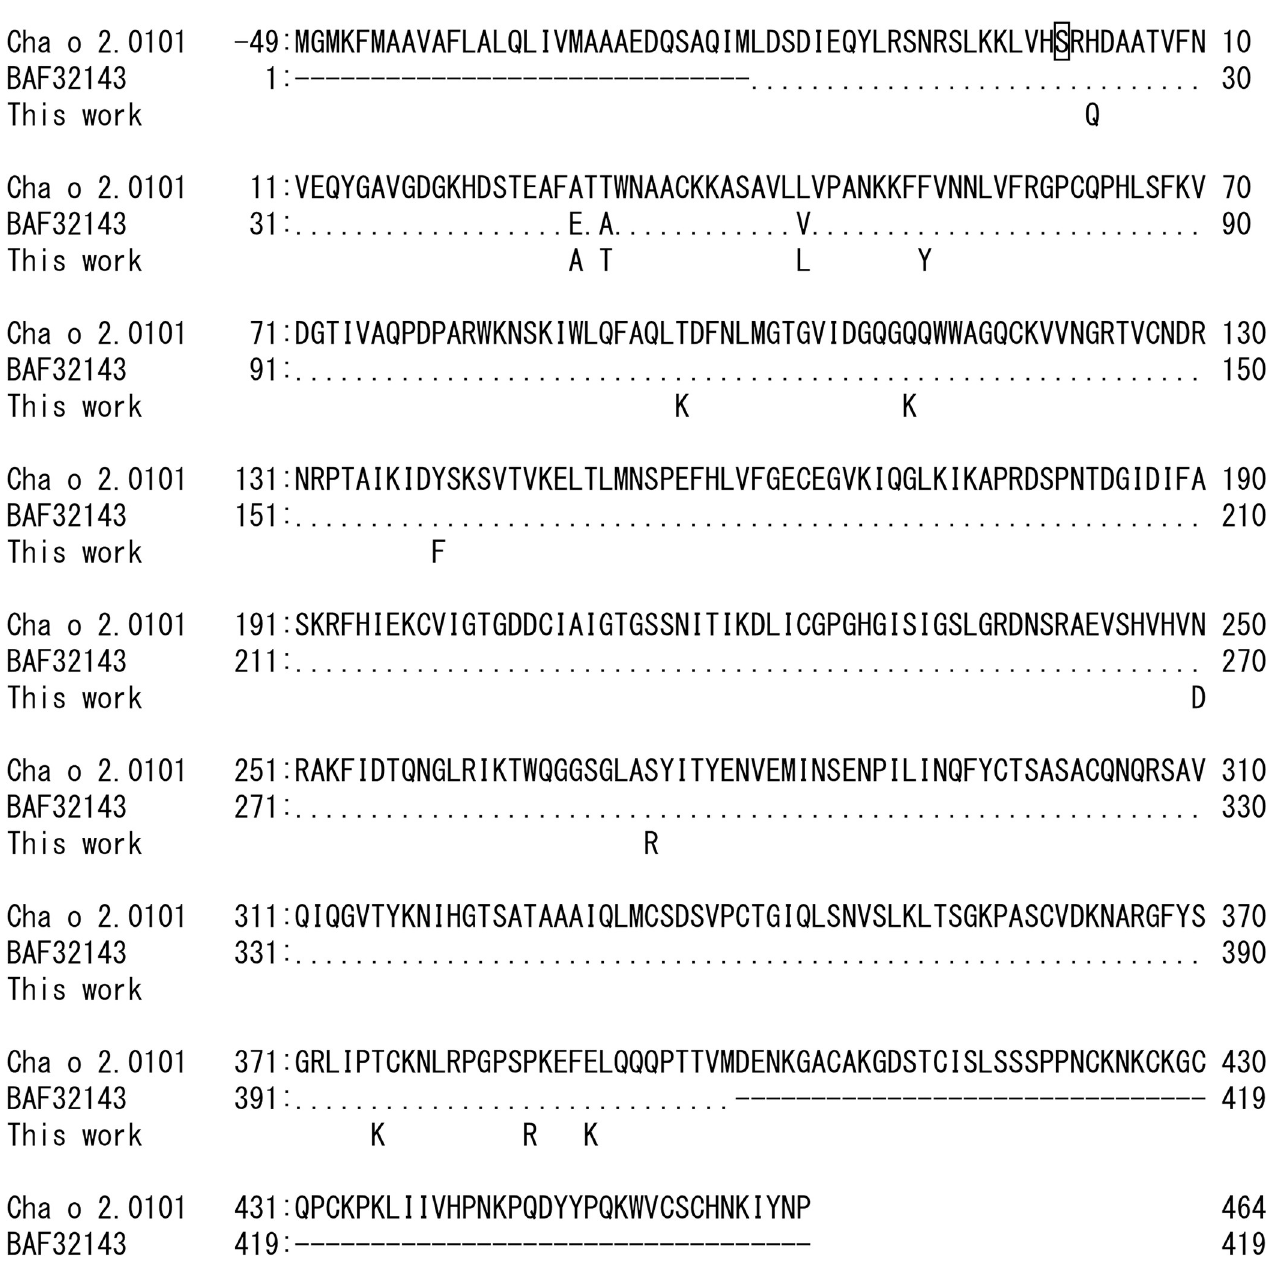
Fig 1. Comparison of amino acid sequences of isoallergen Cha o 2.0101 and those deduced from genomic sequence data of the Cha o 2 gene. The N- terminal amino acid of isoallergen Cha o 2.0101 after processing is boxed and numbered as 1 [15, 16]. The three residues that differed in BAF32143 [22] are indicated and other residues are shown as ‘.’. Undetermined residues are shown as ‘–‘. Substitutions discovered in this study are shown below the BAF32143 sequence.